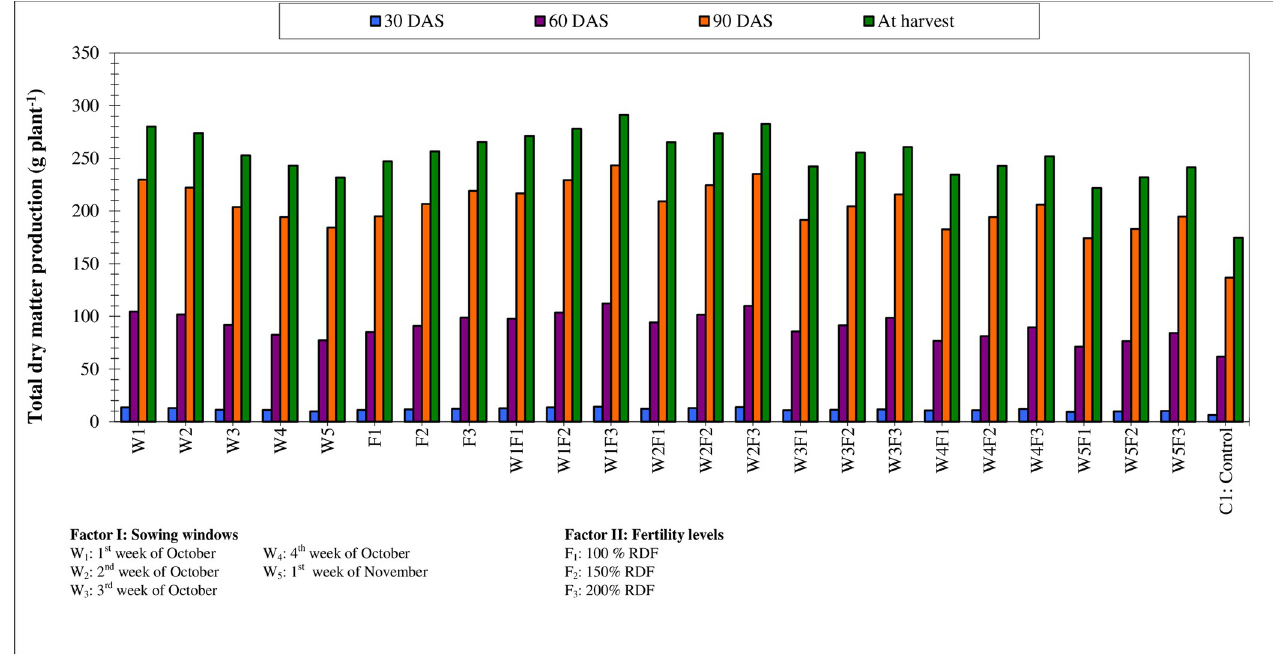
Fig 3. Total dry matter production at different growth stages of winter maize as influenced by sowing windows and fertility levels.